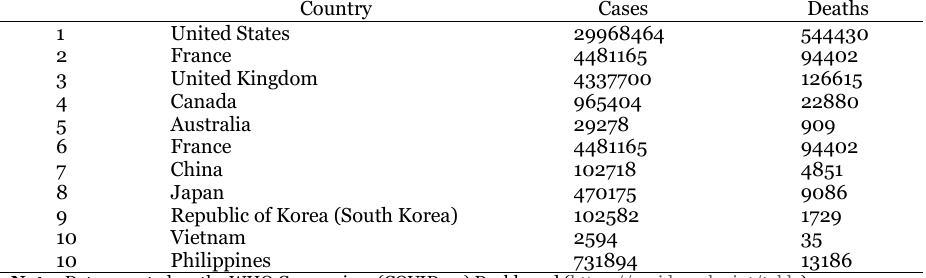
Table 1. Cumulative Infections and Deaths in Select Countries Outside and Inside of Asia Country Cases